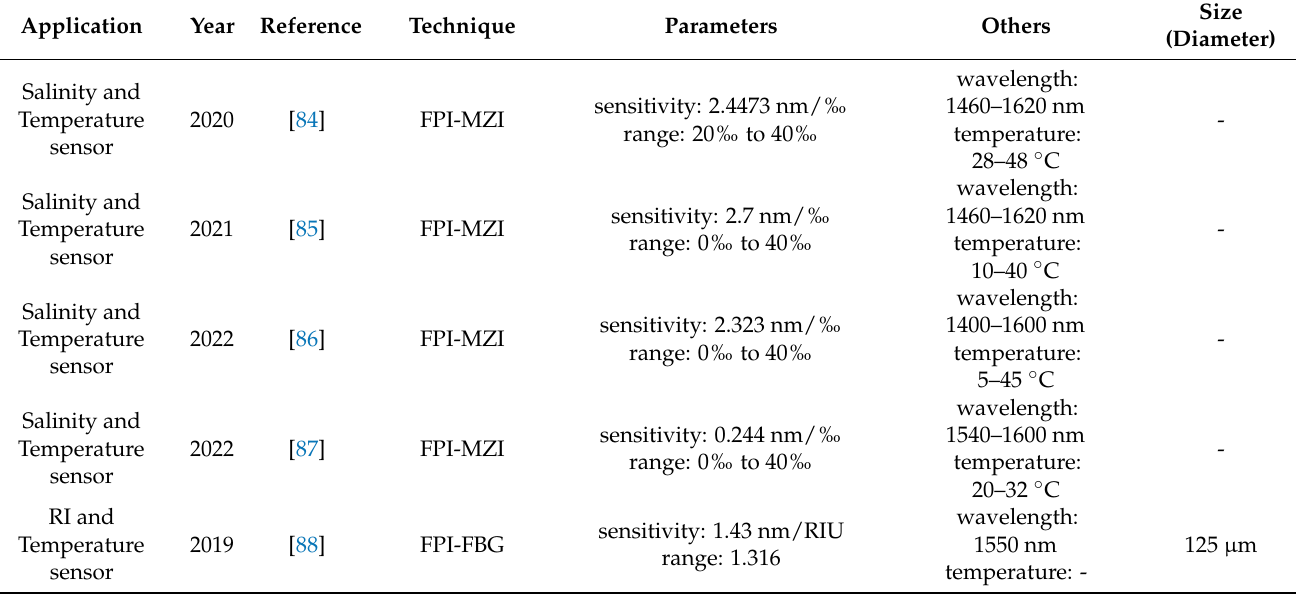
Table 6. Summary of hybrid